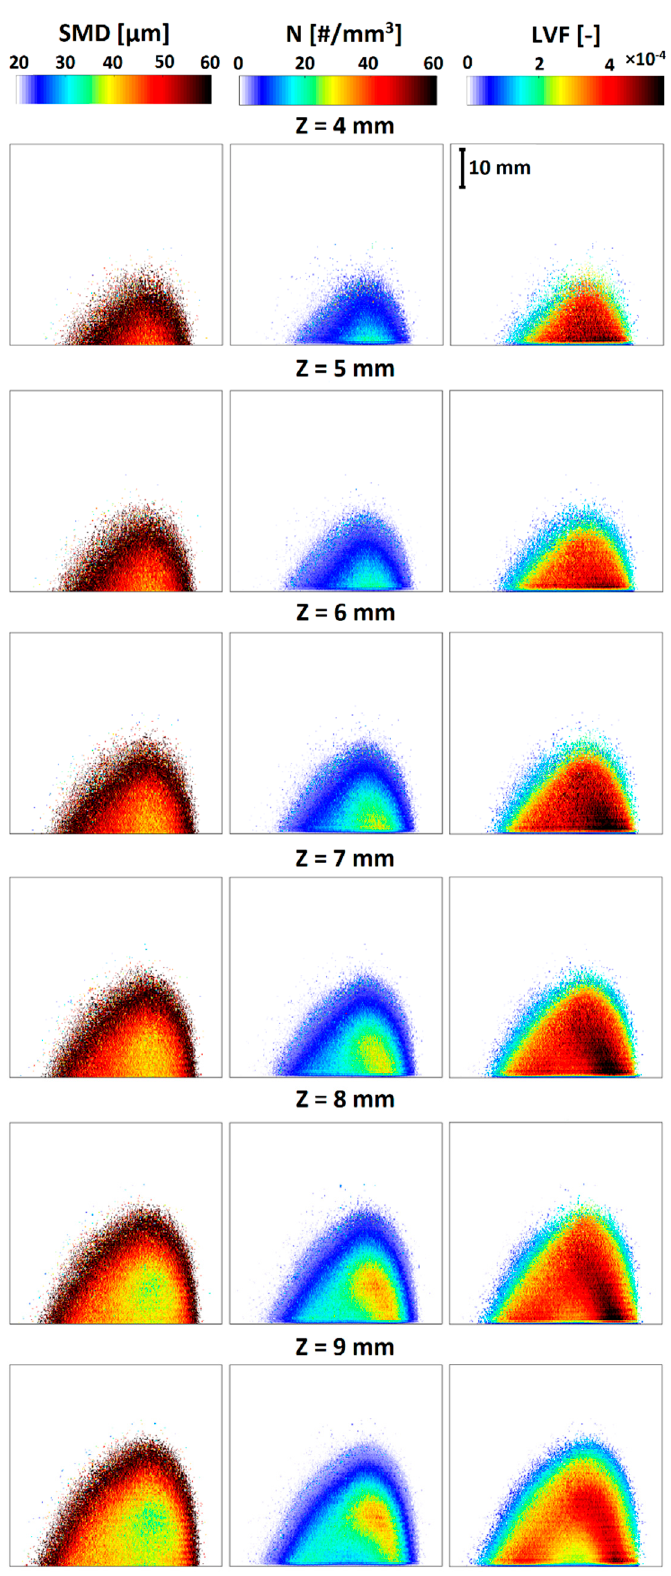
Figure 9. Two-dimensional maps of droplet SMD, N, and LVF, for spray sections at Z = 4, 5, 6, 7, 8, and 9 mm. Droplet SMD varied in the range of 35 to 60 µm. Droplet N varied in the range 5–35 droplets per mm 3 . LVF values from a minimum of 0.1 × 10 − 4 to a maximum value of 5.5 × 10 − 4 .